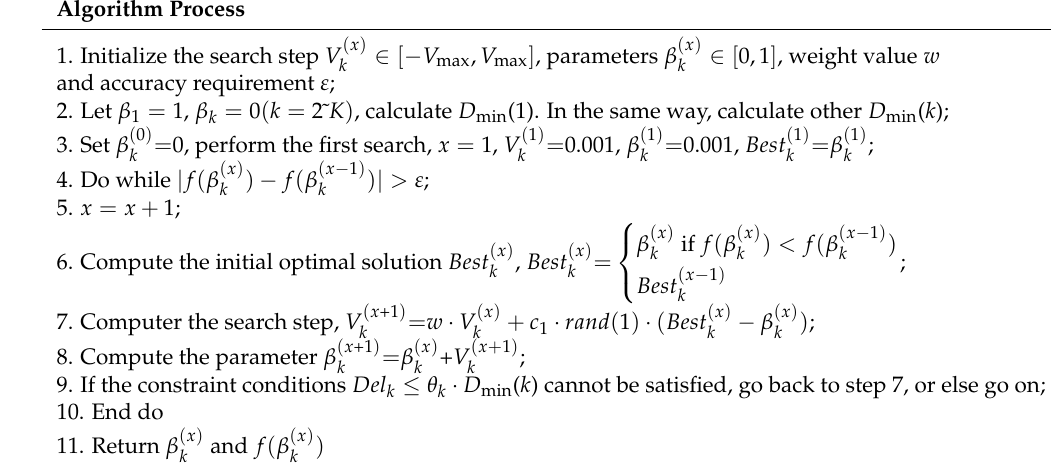
Table 1. Particle swarm optimization (PSO)